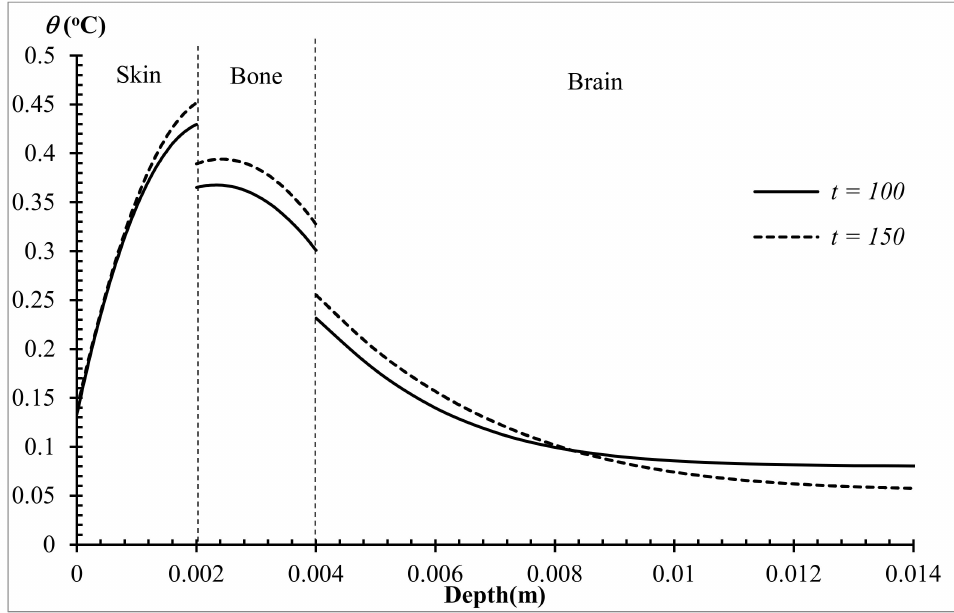
Figure 19. The dynamical temperature increment with various times on a child’s